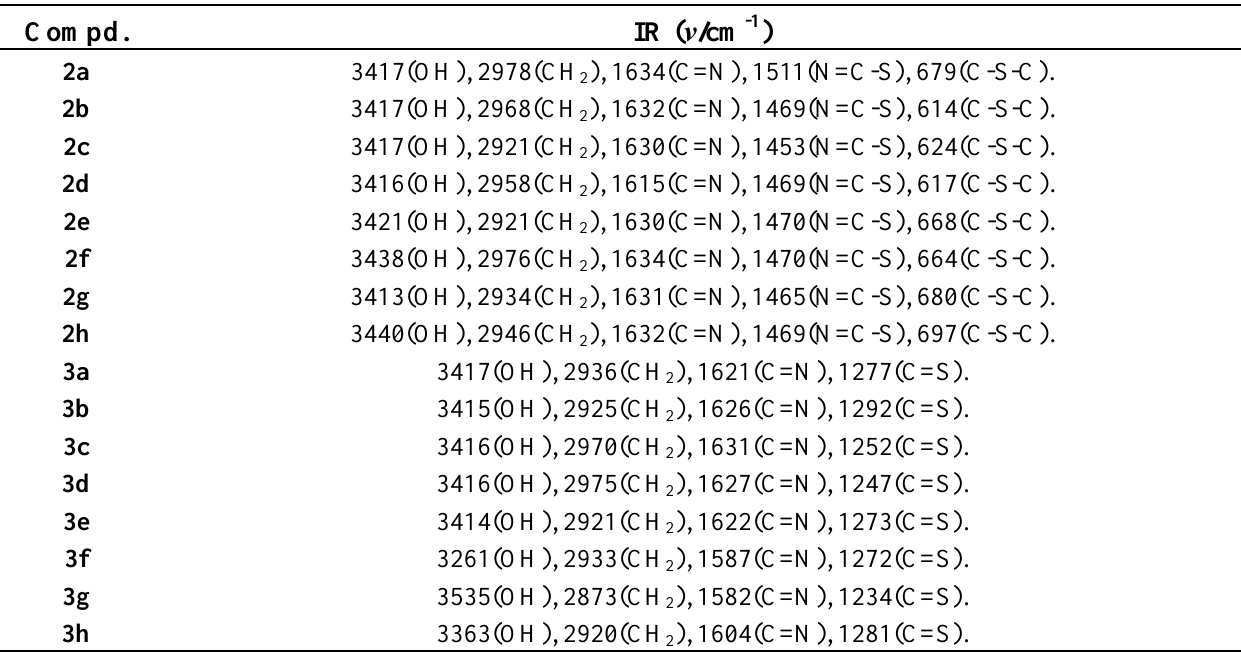
Table 3. IR data of compounds 2a ~ 2h , 3a ~ 3h .